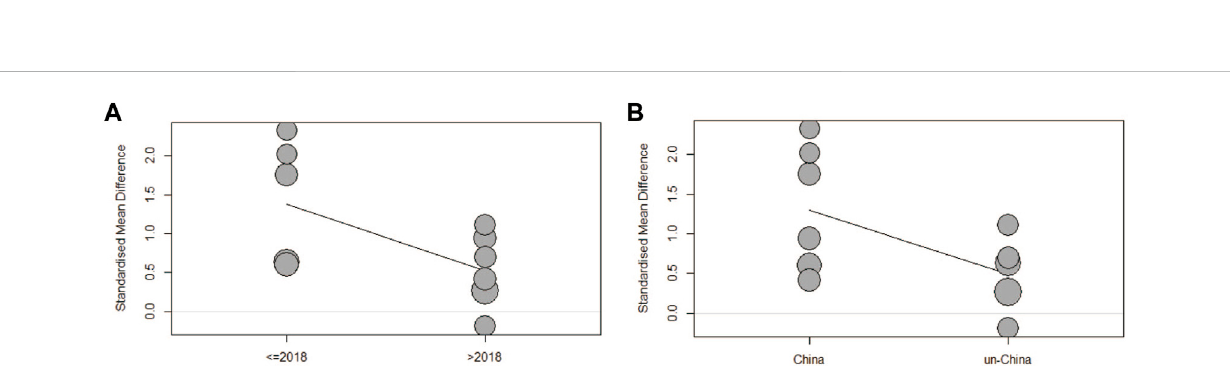
FIGURE 9 (A) RegressionanalysisofyearofpublicationandSMD. (B) RegressionanalysisbetweencountriesofpublicationandSMD.(SMD:standardizedmean